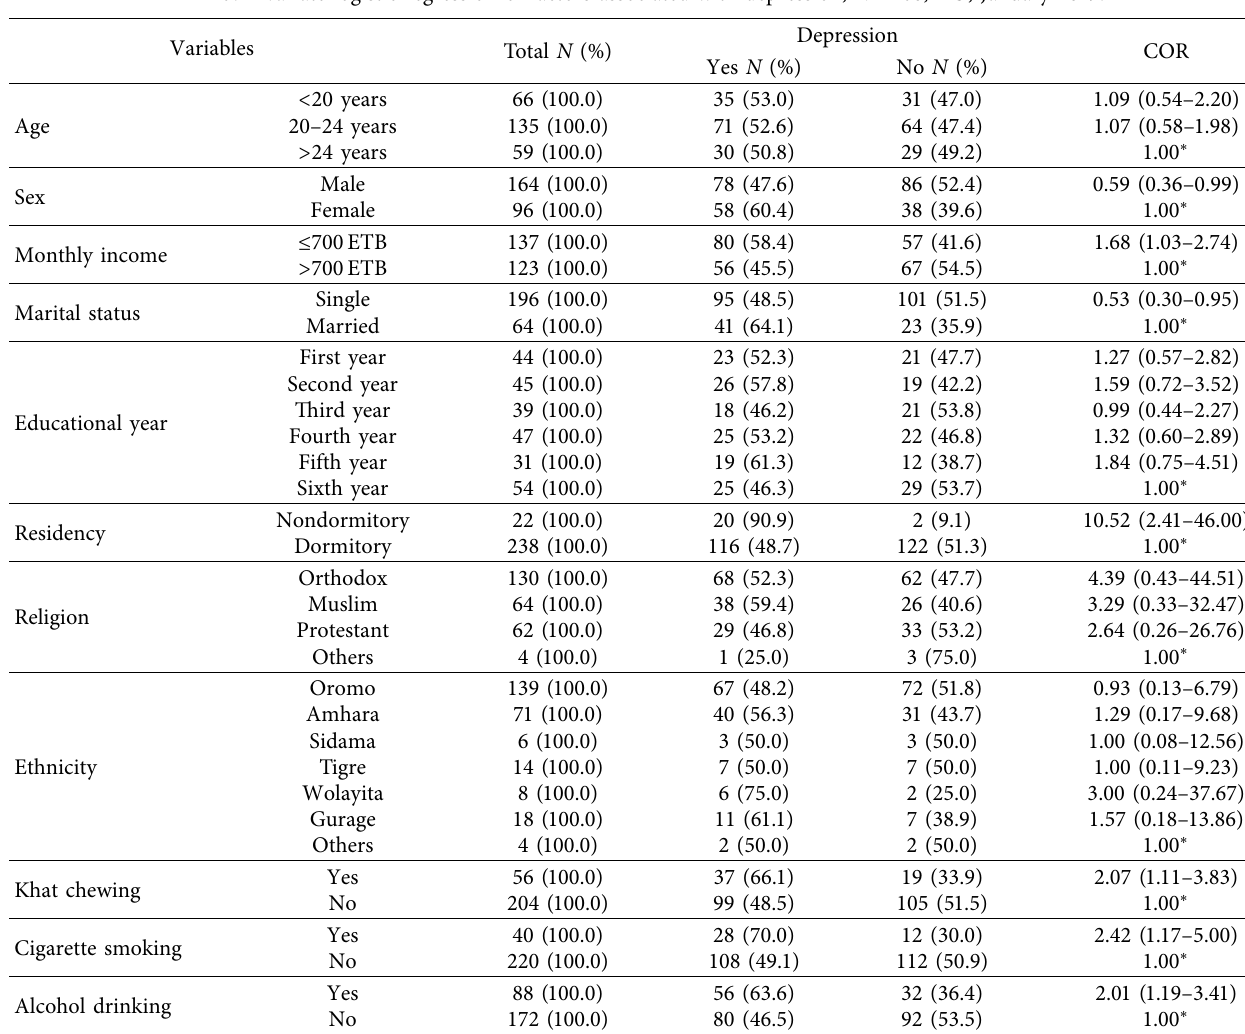
Table 5: Bivariate logistic regression of factors associated with depression, N � 260, AU, January 2019. Variables Total N (%)